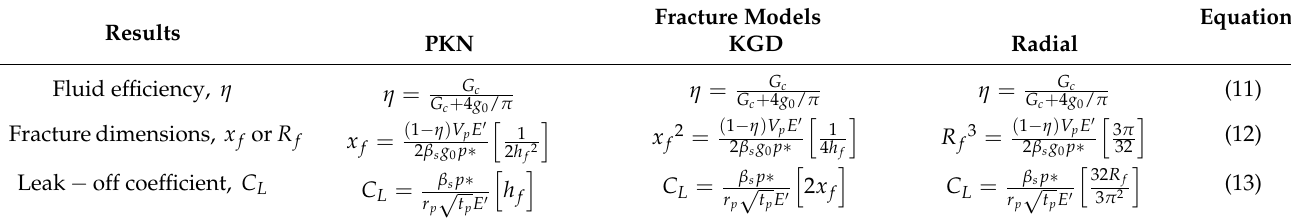
Table 3. Primary outcomes from a DFIT based on stipulated fracture